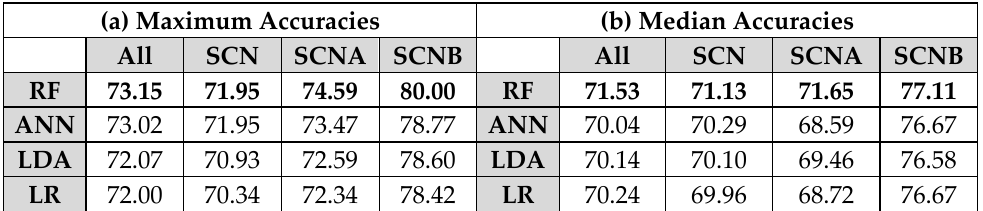
Table 7. ( a ) Maximum accuracies and ( b ) median accuracies for all combinations of beam modes, showing the performance of the algorithms RF, ANN, LDA, and LR.